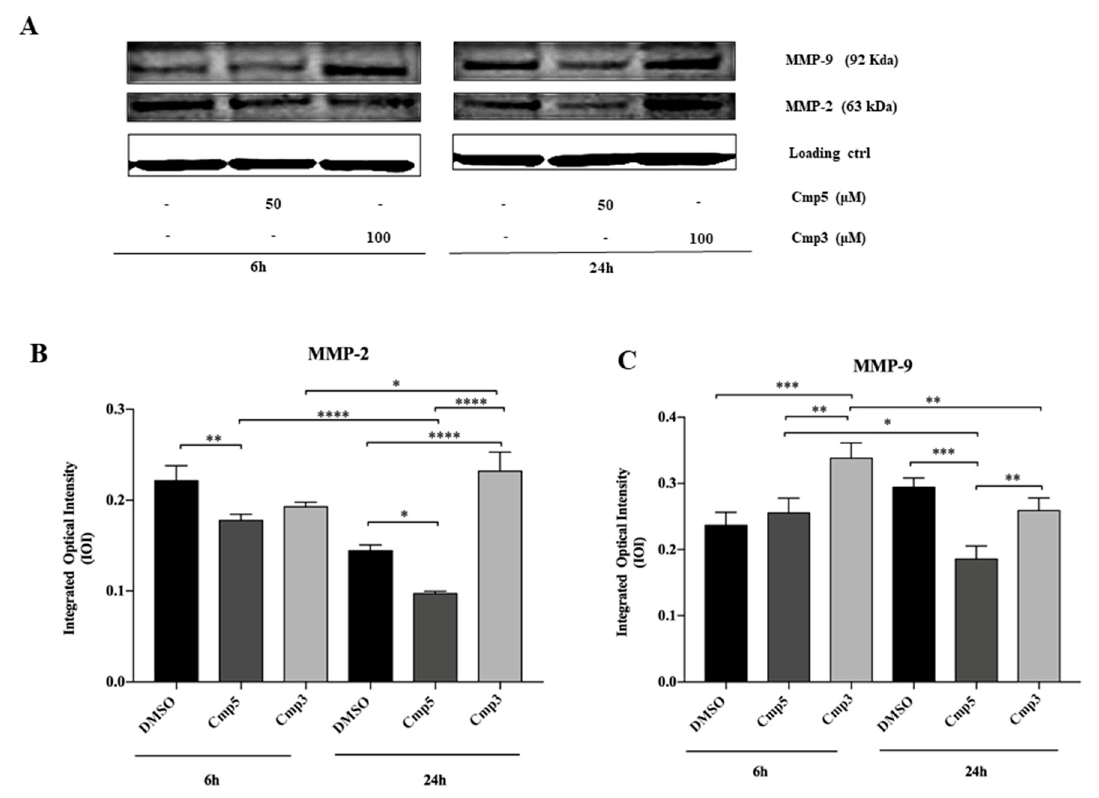
Figure 10. Western blotting analysis of MMP-2, MMP-9 expression in rat C6 glioma cell lines treated with Cmp 5 and Cmp 3 . ( A ) Cells treated with DMSO (0.2%) were loaded as negative control. Each membrane has been probed with β –actin antibody to verify loading consistency. Western blot is the most representative of three di ff erent experiments. ( B , C ) Histograms represent densitometric measurements of proteins bands expressed as integrated optical intensity (IOI) mean of three separate experiments. The error bars on these graphs show standard deviation ( ± SD). **** p < 0.0001, *** p < 0.0002, ** p < 0.0005, * p < 0.005.